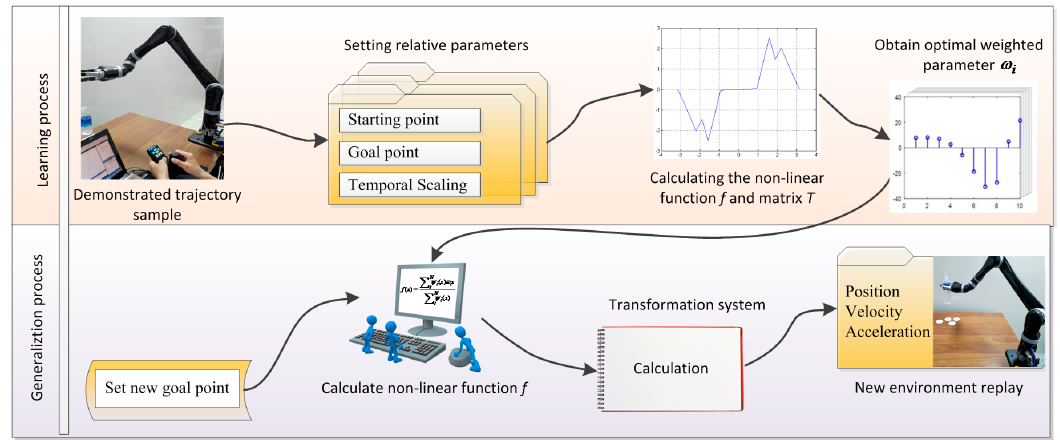
Figure 1. Learning and generalization process of dynamic movement primitives (DMPs).